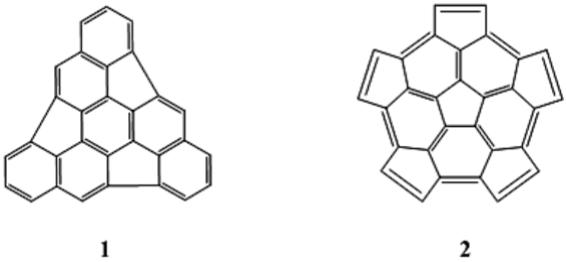
Figure 1. Triindenetriphenilene ( 1 ) and pentacyclopentacorannulene ( 2